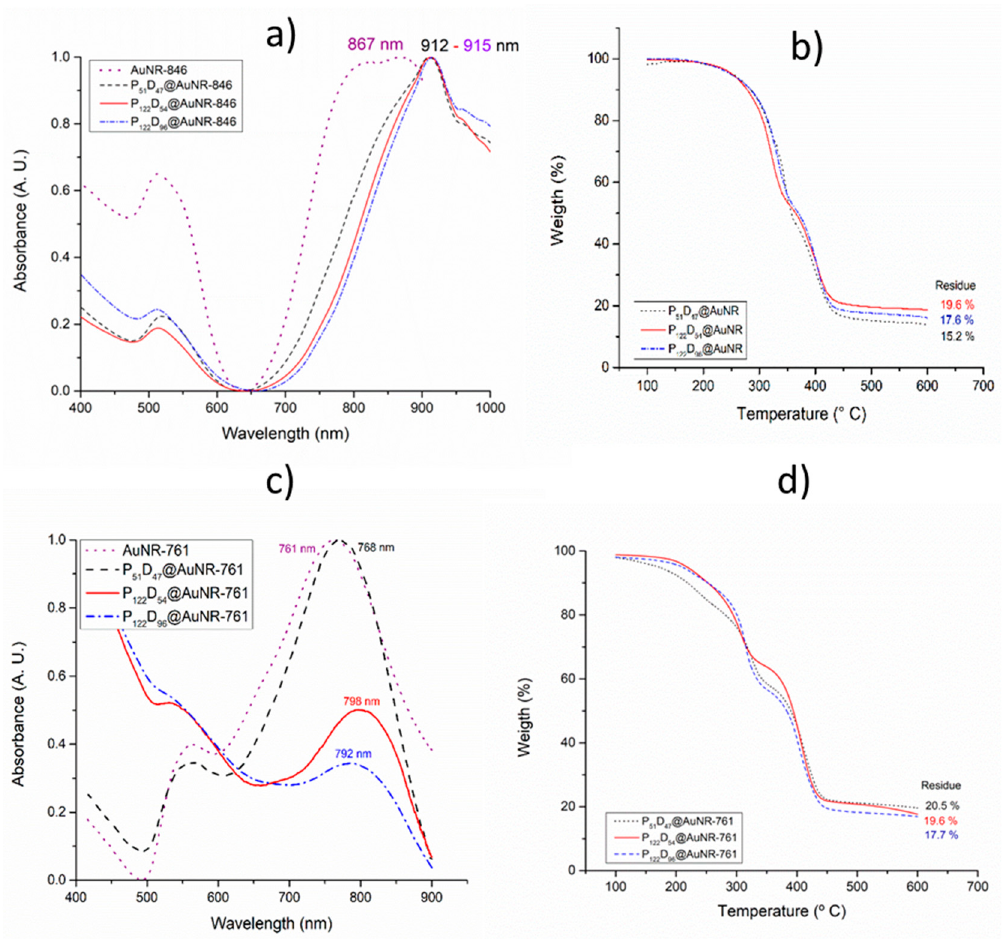
Figure 8. Gold nanorod filled polymersome’s characterization: ( a ) UV-Visible spectrum, and ( b ) TGA